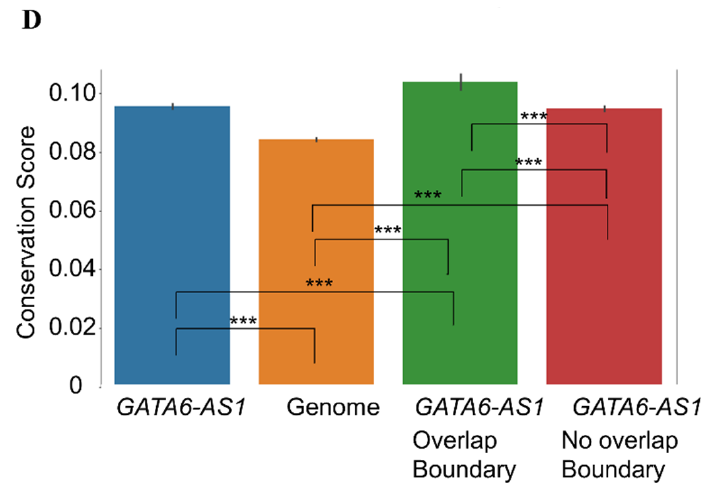
Figure 3. Characteristics of GATA6-AS1 triplex sites in relationship to CTCF, repeat elements, and conservation. ( A ) The probability of binding of CTCF ( y -axis) to different regions of the GATA6-AS1 sequence ( x -axis) is shown. ( B ) Boxplots comparing the amount of CTCF signal at GATA6-AS1 triplex sites and a control set (genome). *** indicates p -value < 0.001. ( C ) Fraction ( y -axis) of the length of GATA6-AS1 triplex sites occupied by four groups of repeat elements (LTR, SINE, LINE, and DNA transposons) is compared to a control set (genome). GATA6-AS1 triplex sites are further grouped into two groups based on whether it is associated with TAD boundaries or non-TAD boundaries. For each type of repeat element, six statistical comparisons were tested and only the ones which showed significant differences are marked as ***. ( D ) Conservation score per base pair ( y -axis) is shown for GATA6-AS1 triplex sites and a control set (genome).